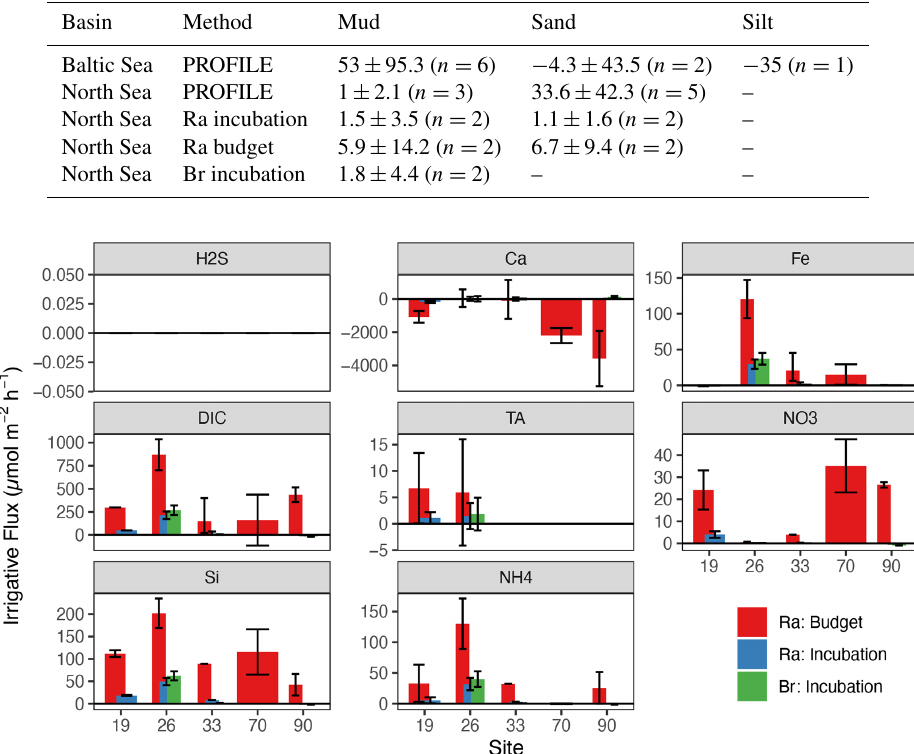
Table 2. Comparison of average TA fluxes (µmolm − 2 h − 1 ) between methods in the North and Baltic seas, separated by sediment type.